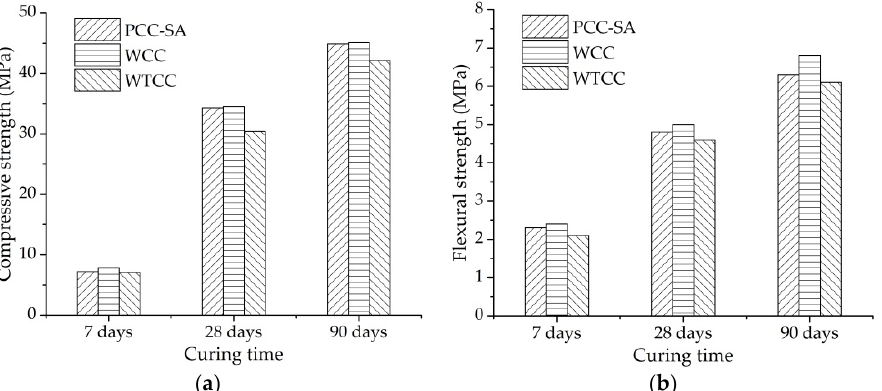
Figure 6. Compressive and flexural strength of different pavements: ( a ) compressive strength; ( b ) flexural strength. The compressive strength and the flexural strength increased with the curing time.